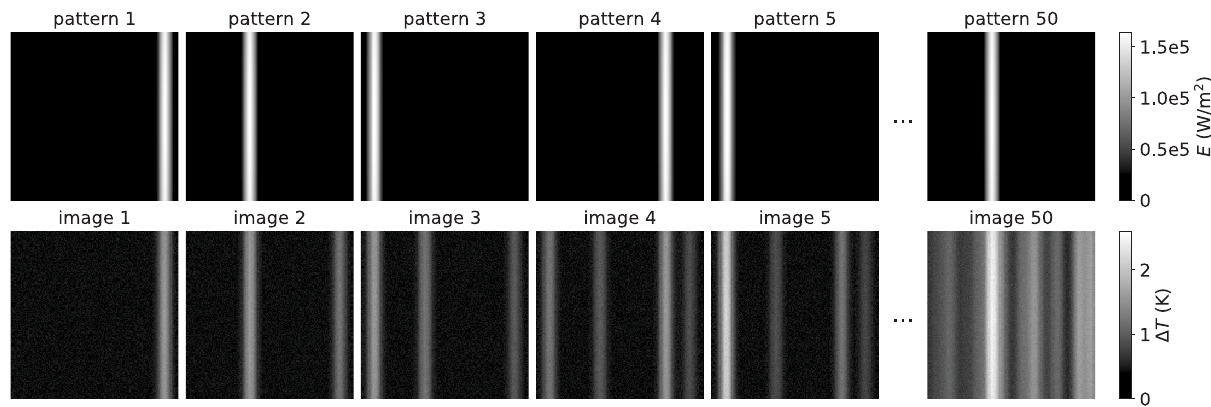
Figure 2. Example projection sequence of single fringe patterns for a sequence length of N = 50 and random positioning in the top row and corresponding MWIR camera images in the bottom